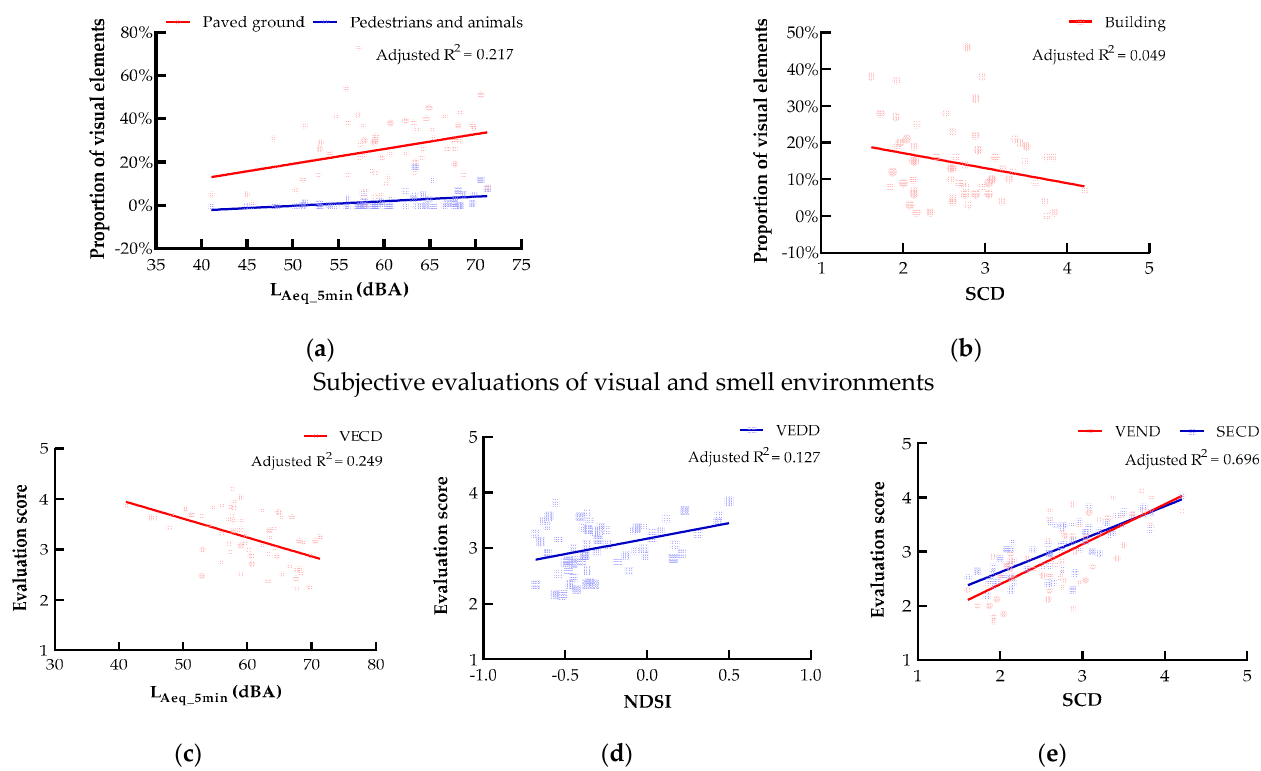
Figure 8. Linear regression curves between the proportion of visual elements and soundscape evaluation parameters, and subjective evaluations of visual and smell environments and soundscape evaluation parameters: ( a ) the proportion of visual elements and L Aeq_5min ; ( b ) the proportion of visual elements and SCD; ( c ) subjective evaluations of visual and smell environments and L Aeq_5min ; ( d ) subjective evaluations of visual and smell environments and NDSI; ( e ) subjective evaluations of visual and smell environments and SCD.